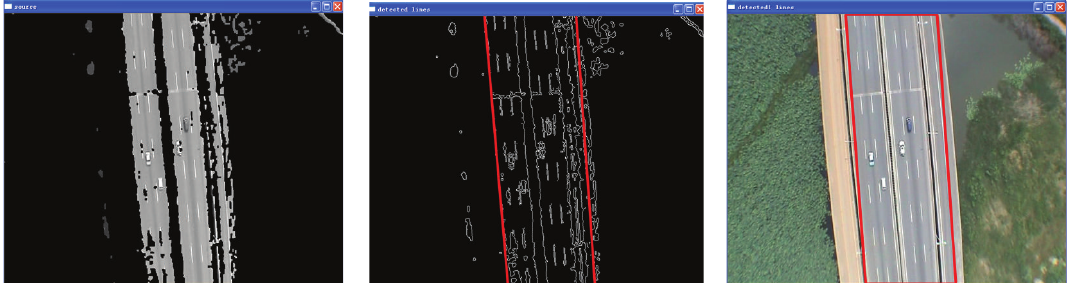
Figure 6: Road extraction results.